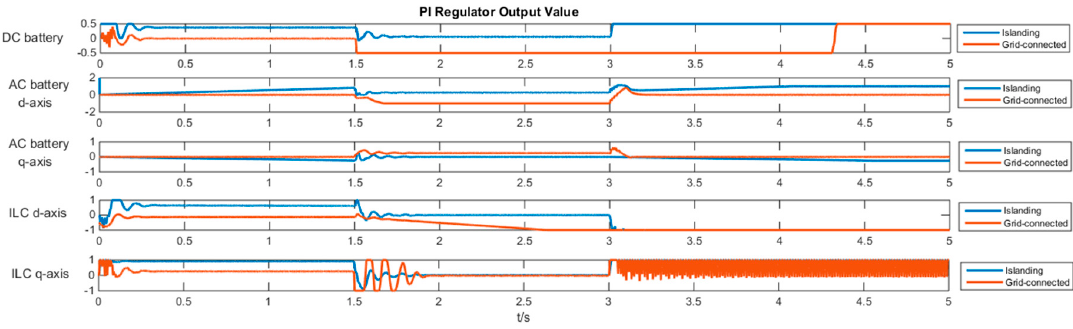
Figure 13. Regulation state of the direct transition control.